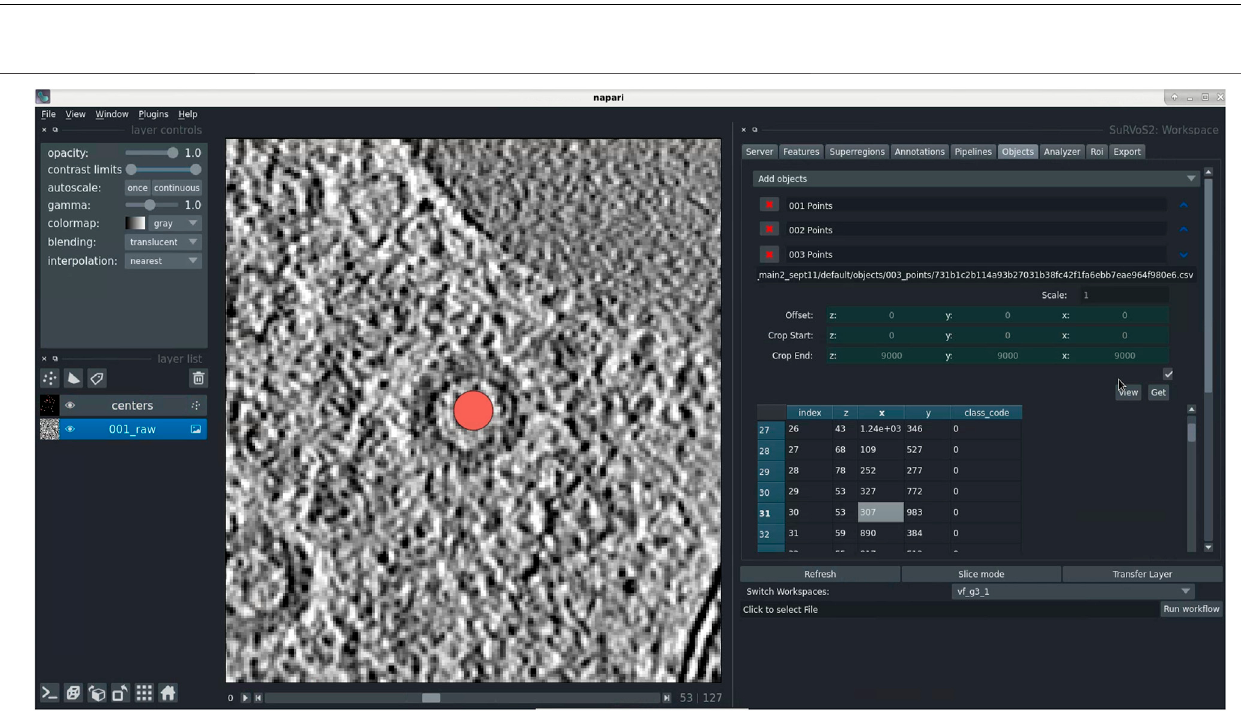
Frontiers in Cell and Developmental Biology |